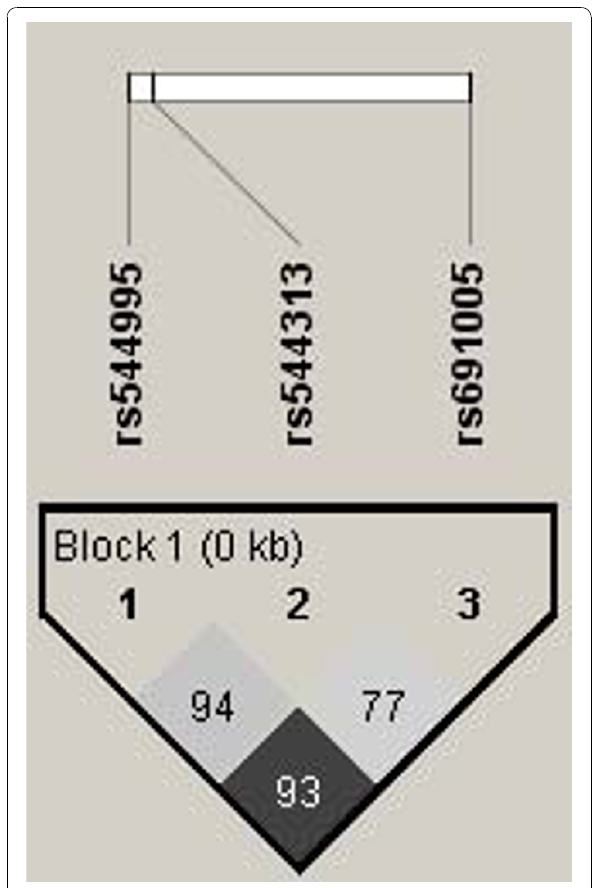
Figure 2 Linkage disequilibrium structure (LD) of 3 SNPs (rs544995, rs544313 and rs691005) in MRC1 gene. Black squares represent high pairwise linkage disequilib. The numbers in the individual squares are D ’ multiplied by 100.